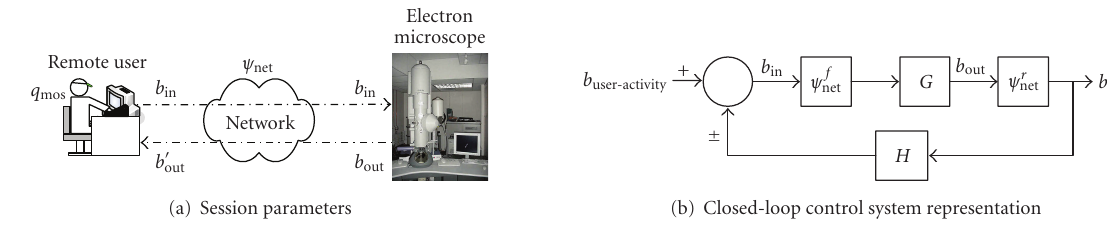
Figure 1: Basic remote microscopy